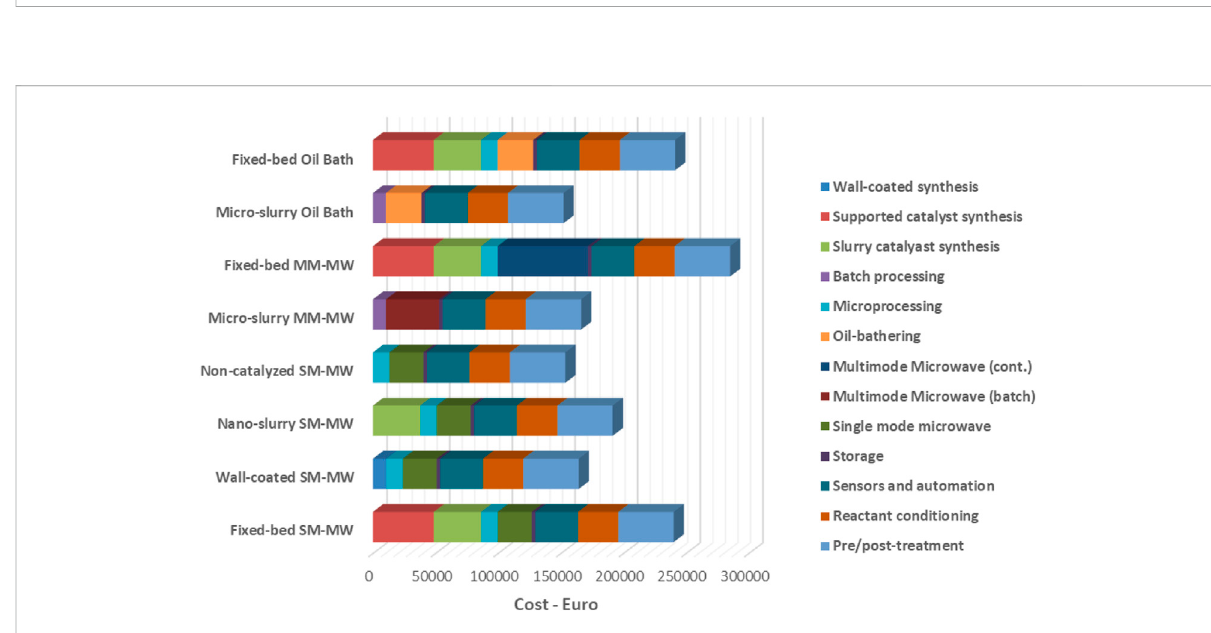
FIGURE 9 MAOS cost bene fi ts outlook for Multi-Mode MM-MW and Single-Mode SM-MW (Authors ’ graphic inspired by Benaskar et al.,